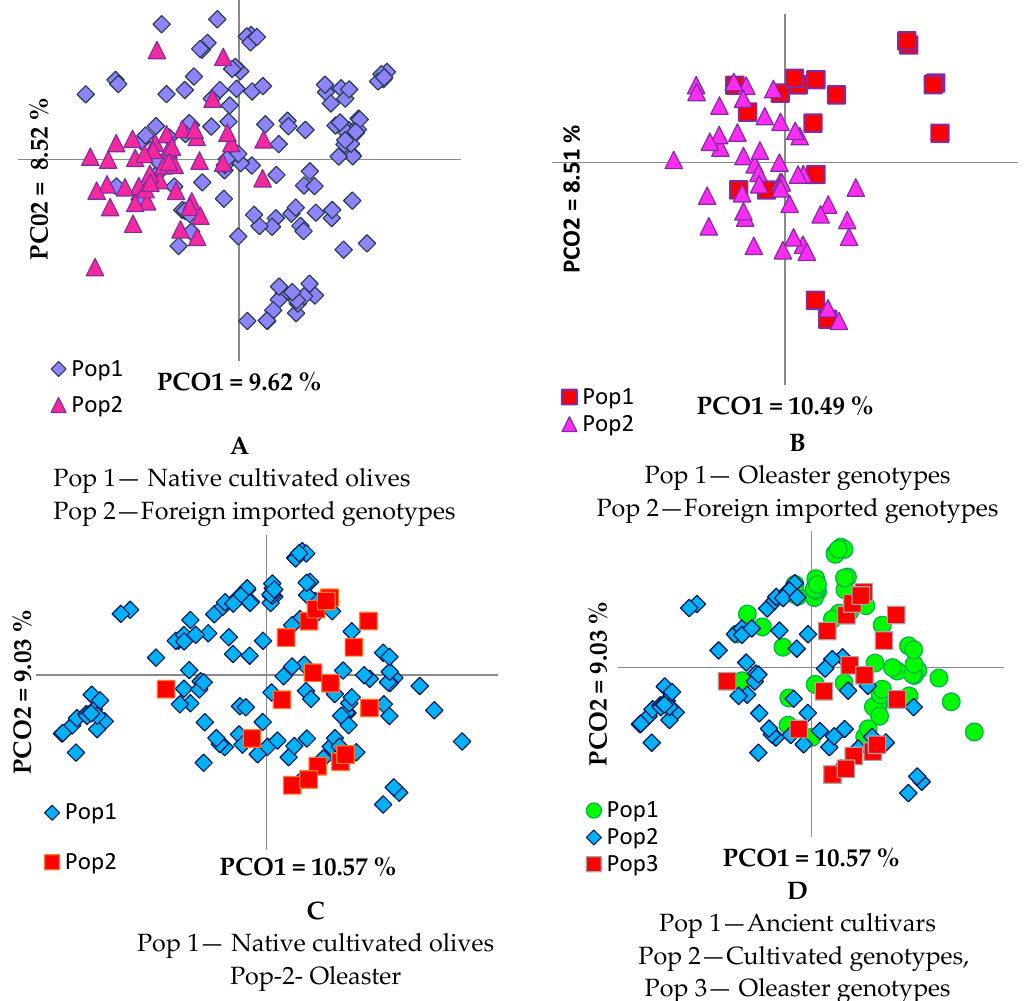
Figure 2. Principal coordinate analysis of olive genotypes based on their origin ( A , B ) and breeding ( C , D ). The PCoA explained a total variation of 23.21% (Figure 1). The first principal coor- dinate accounted for 9.22% of the total variation and allowed the discrimination of